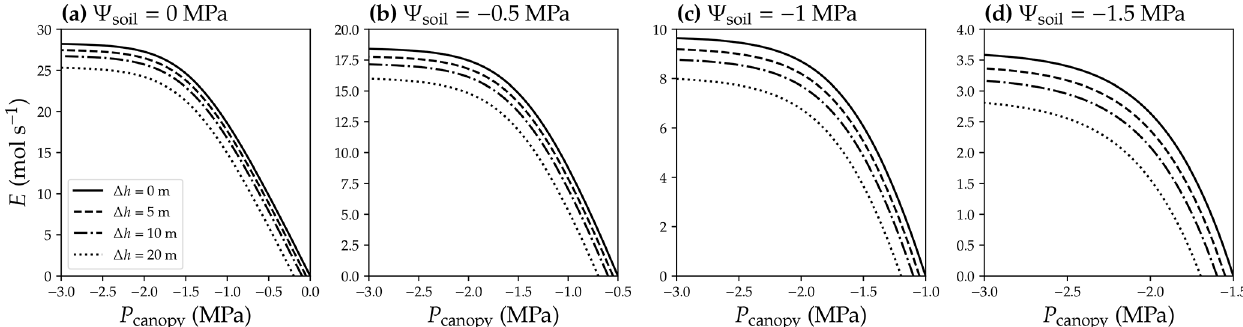
Figure 4. Water supply curve at different (cid:57) soil values for xylem with different height change. The simulation is done assuming there is no drought legacy effect from previous xylem embolism. See Table 1 for the list of symbols.